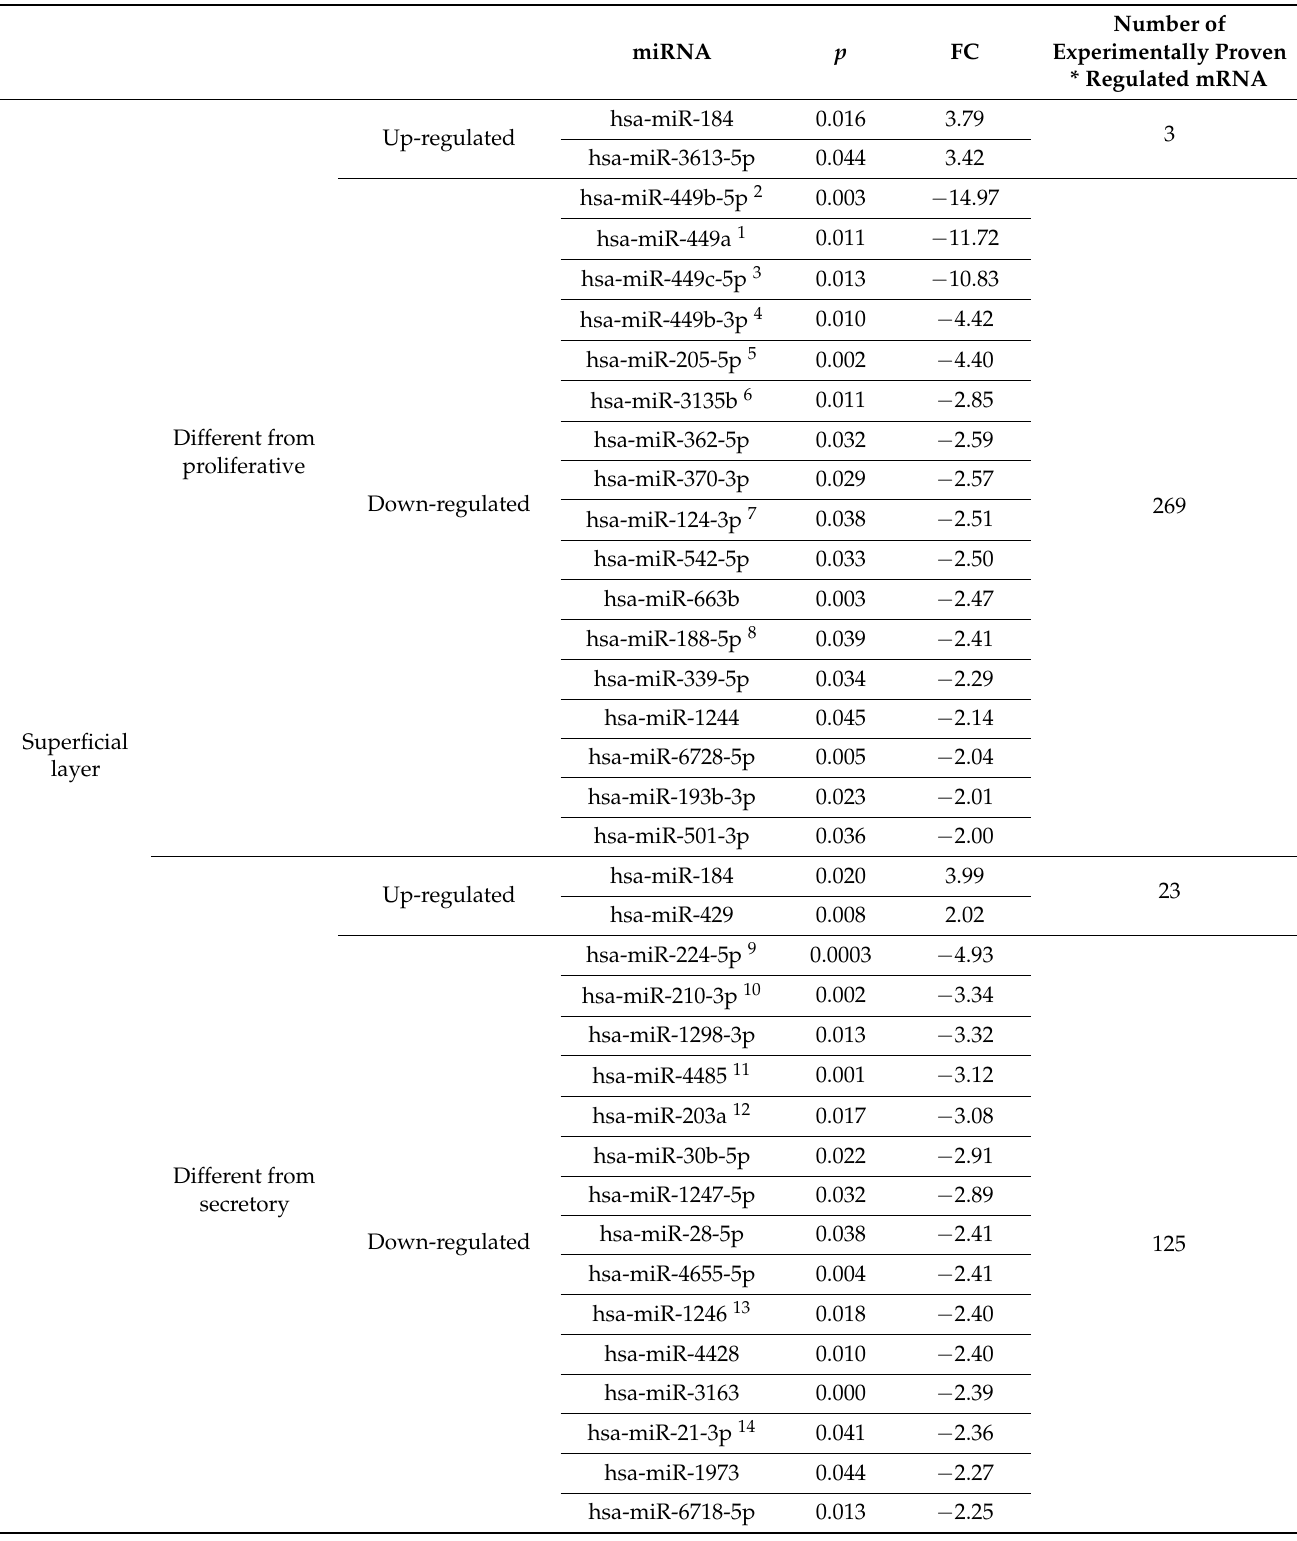
Table 1. List of up- or down-regulated miRNA in the UPA group as compared to the proliferative or secretory phase groups in each layer of the human